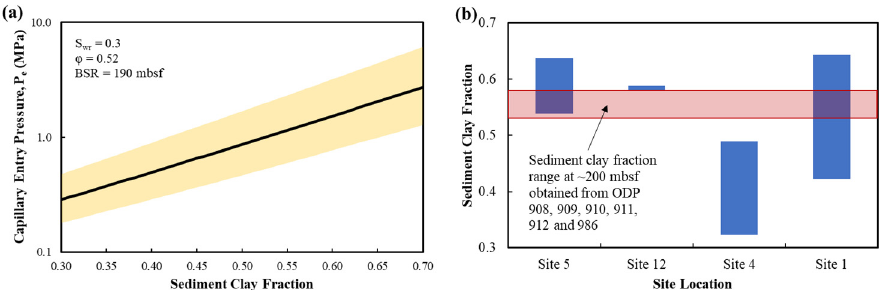
Figure 7. ( a ) The capillary entry pressure ( P e ) (Equation (8)) as function of sediment clay fraction is shown here. The black line is the median prediction and the and the shaded region is the uncertainty ( ± 1 SD). The capillary entry pressure increases with an increase in sediment clay fraction. ( b ) Sediment clay fraction data obtained from the index tests of the upper 20 m of the sediments for the 4 sites compared with the sediment clay fraction obtained from the ODP data.